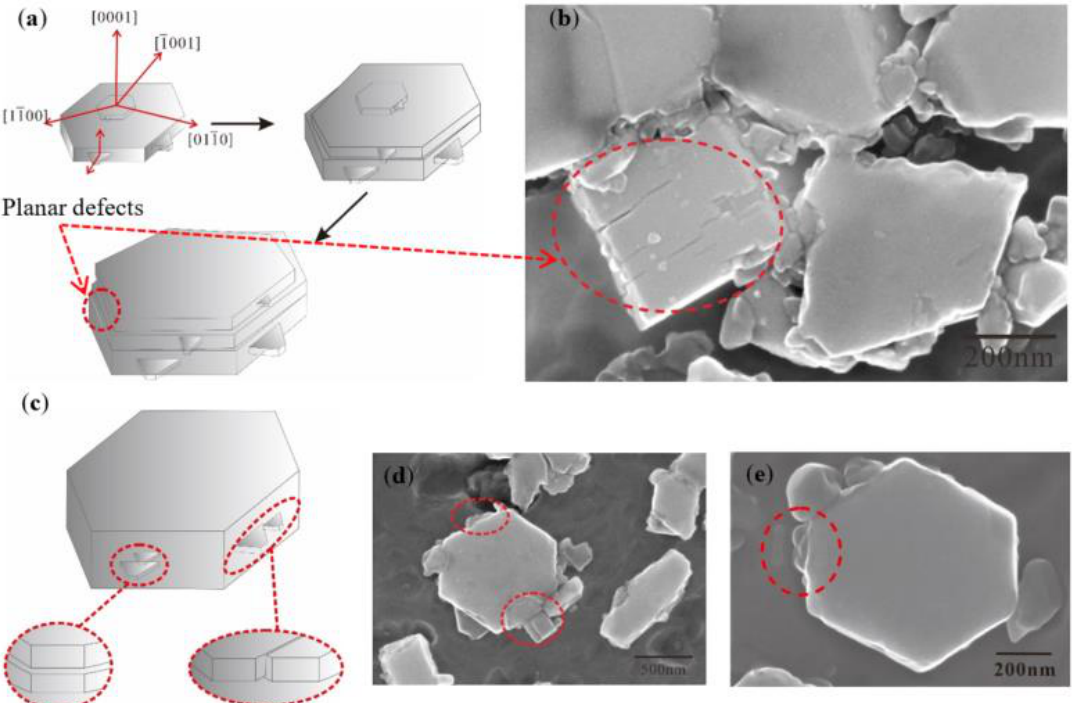
Figure 12. Schematic diagram and microstructure of possible defects in the earlier and later growth stage of TiB 2 for the Al–Ti–B Master Alloy prepared by the halide salt route: ( a ) earlier TiB 2 crystal growth model; ( b ) earlier actual growth of TiB 2 ; ( c ) later TiB 2 crystal growth model; ( d , e ) later actual growth of TiB 2